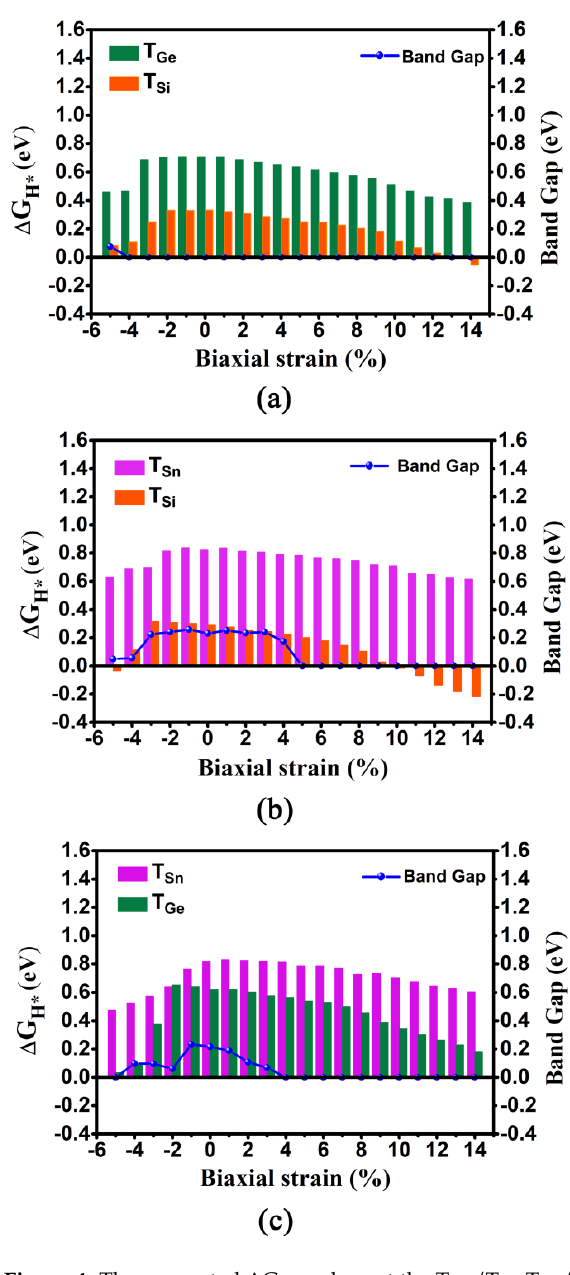
Figure 4. The computed ΔG H* values at the T Ge /T Si , T Sn /T Si , and T Sn /T Ge sites and band gaps, as a function of compressive and tensile biaxial strains for the 2D GeSi ( a ), SnSi ( b ), and SnGe ( c ) sys-